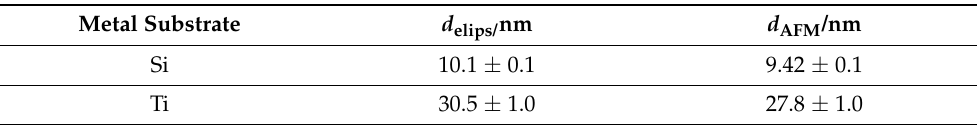
Figure 5. The area where PAH/PAA multilayer was removed from the surface of the Si substrate, recorded by ( a ) digital optical microscope and ( b , c ) atomic force microscope. Figure ( b ) presents a 2D AFM image of the surface, and Figure ( c ) a 3D AFM image. Table 3. Thickness of PAH/PAA multilayers on silicon and titanium substrates determined by ellipsometry and atomic force